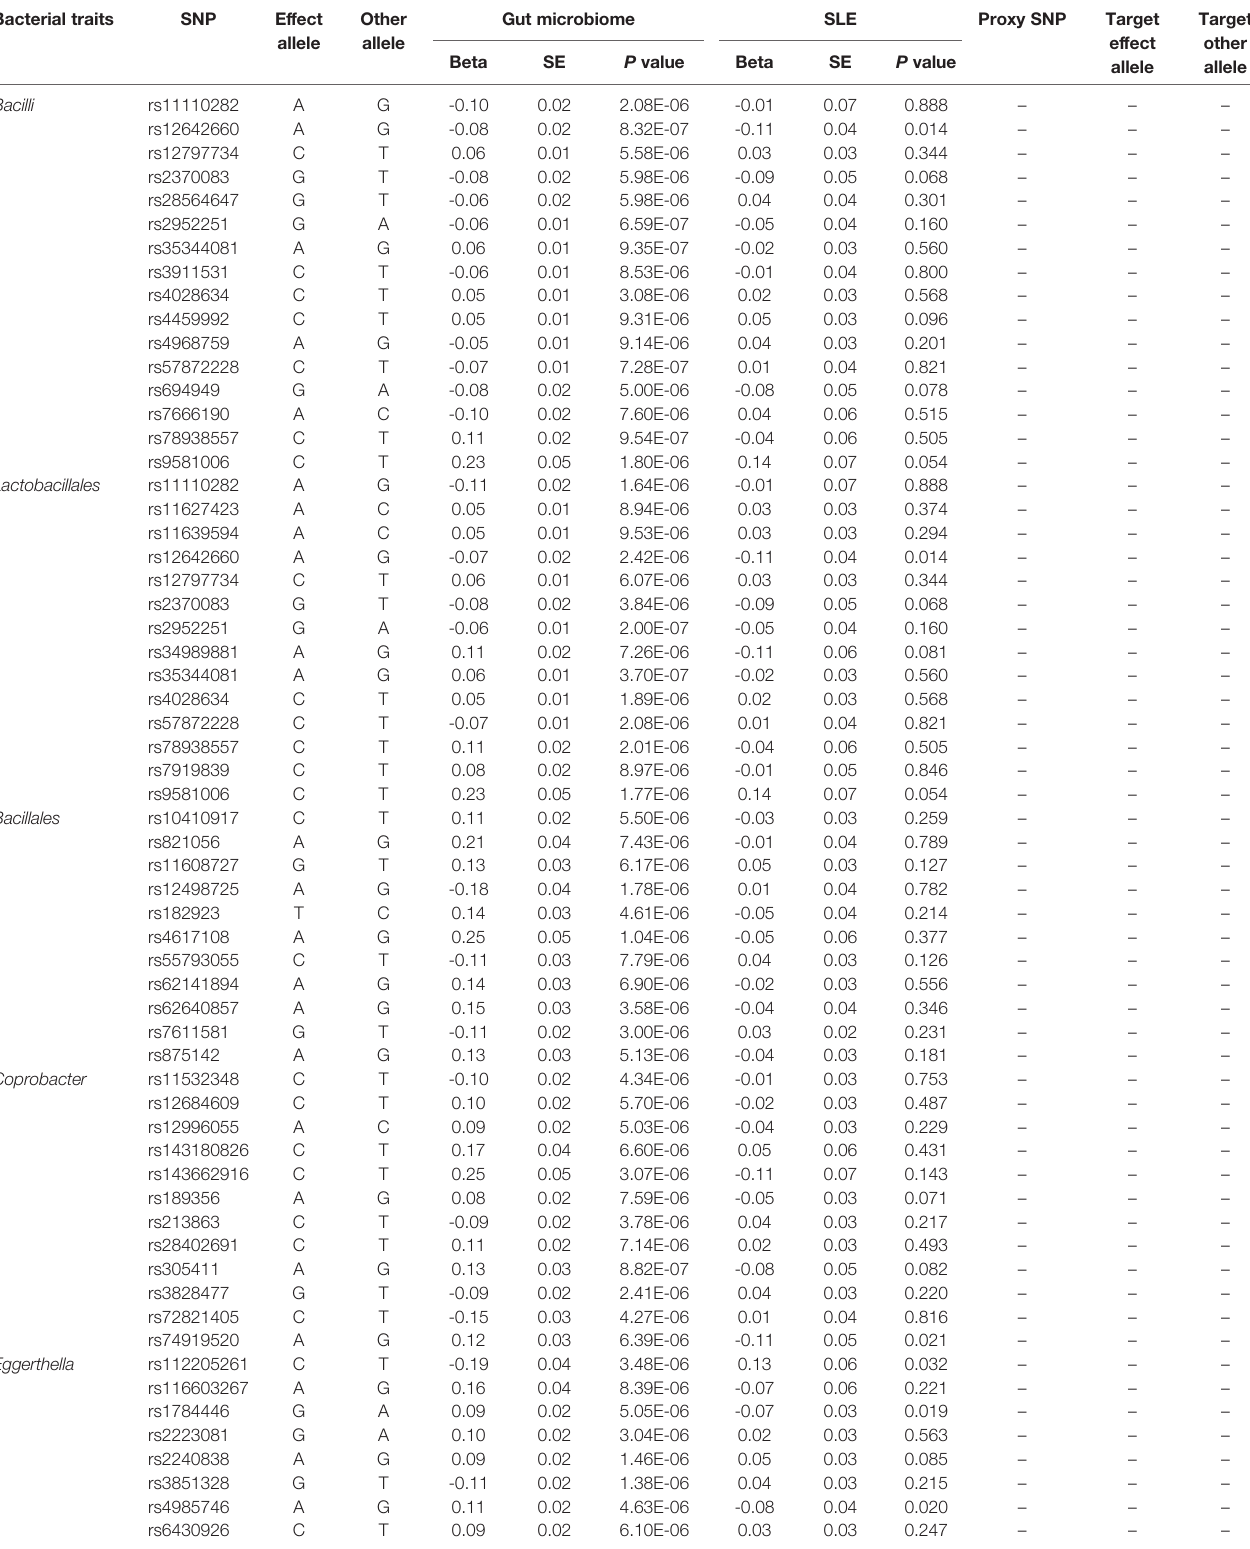
TABLE 2 | SNPs used as instrumental variables from gut microbiome and SLE GWASs ( P < 1 × 10 -5 ). Bacterial